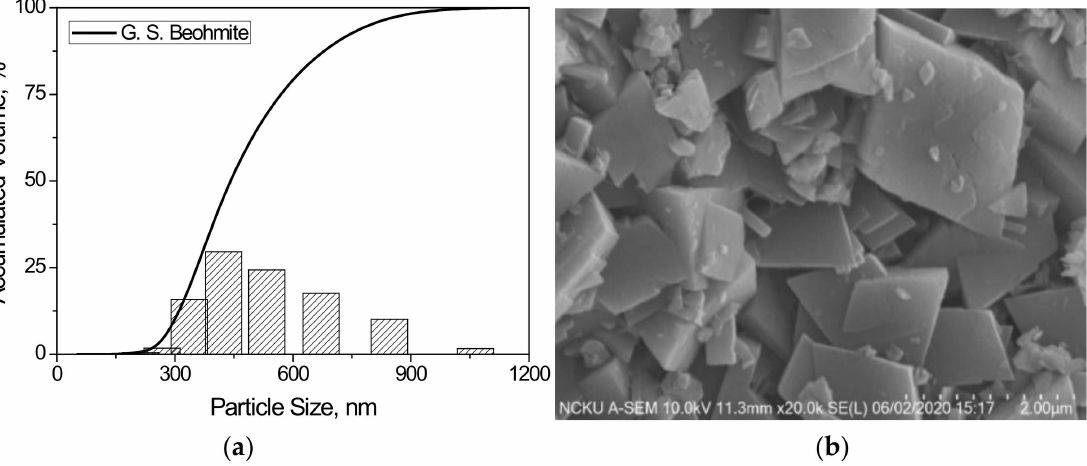
Figure 2. ( a ) Particle size distribution and ( b ) SEM micrograph of starting boehmite powders used in this